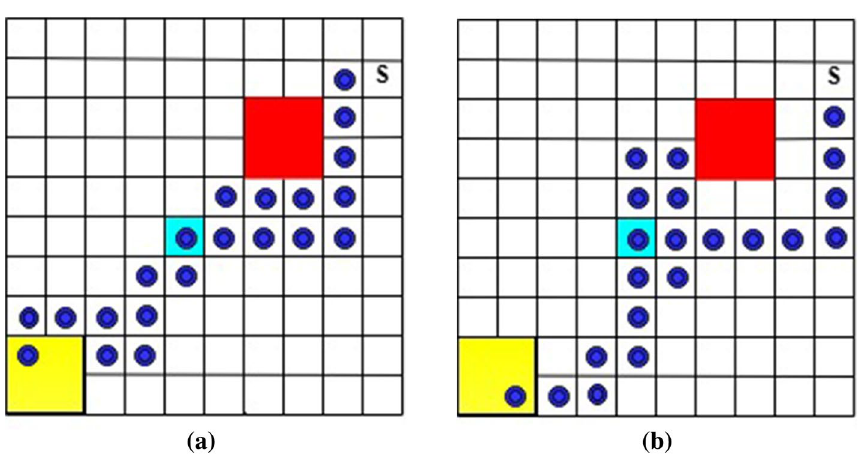
Figure 12. The generated trajectories from the optimal policy learned via Q-learning without safety value